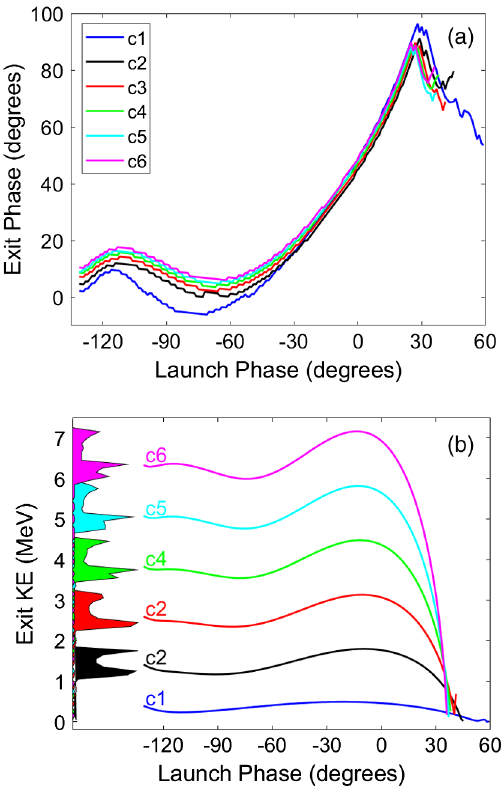
FIG. 2. Results of 1D tracking code simulations of a commer- cial linac with 25 keV initial electrons. Exit phase (a) and exit KE (b) vs launch phase for cells c1 through c6 of the linac. The KE energy in (b) is projected to the y axis to show the KE spectrum in arbitrary units at the corresponding cell